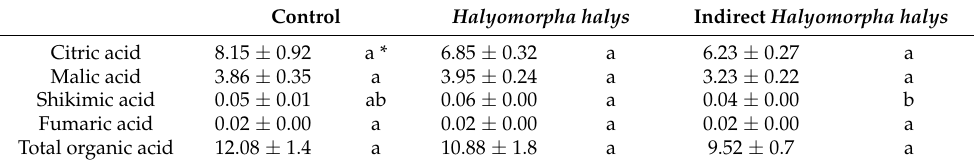
Table 2. Individual and total organic acid content (g/kg FW, mean ± SE) in strawberry fruit.